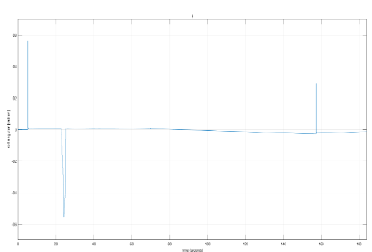
Figure 20. X distance response for the QAV